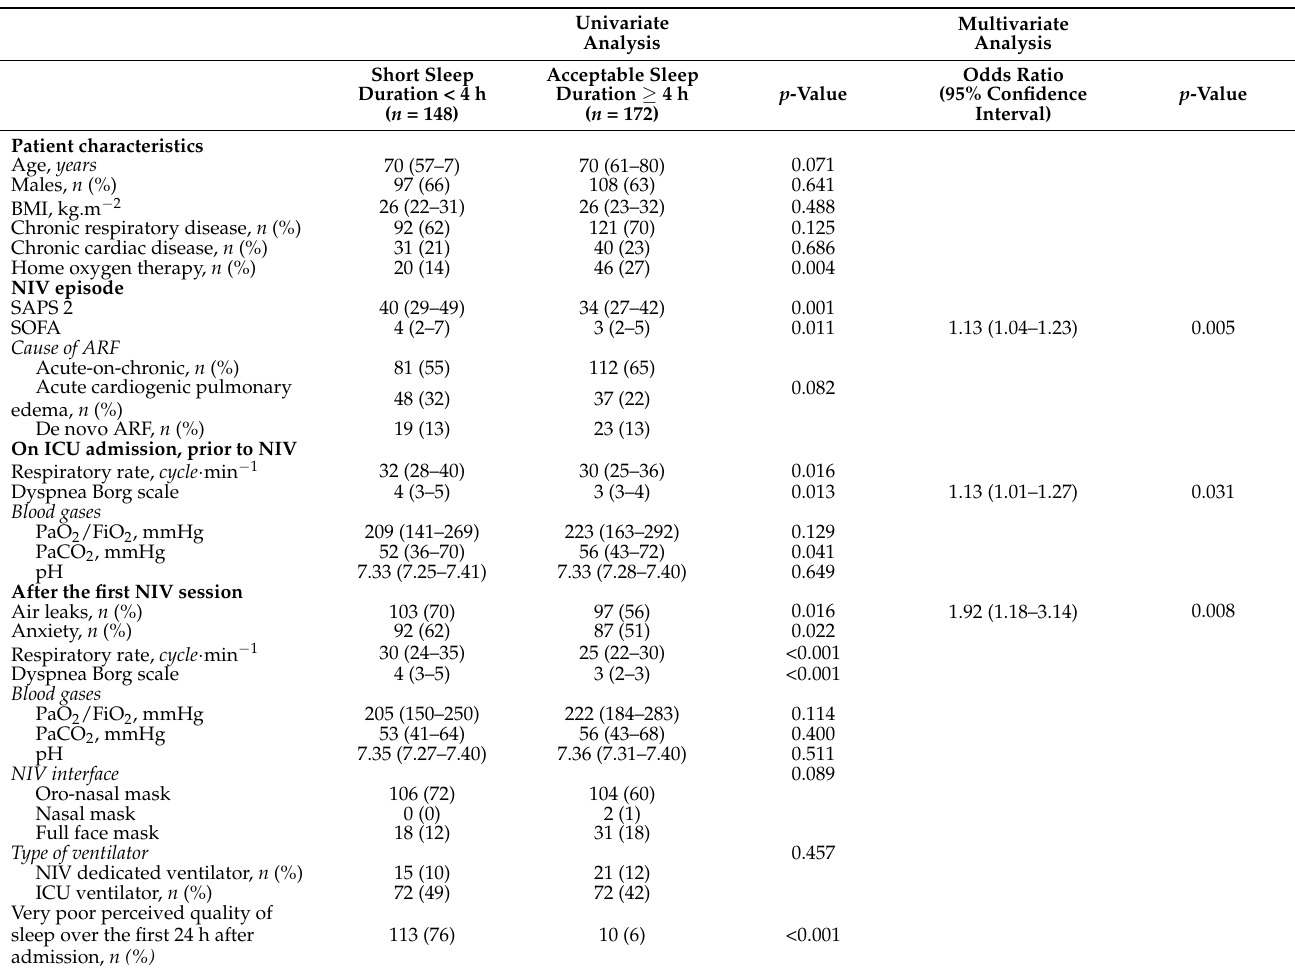
Table 2. Univariate and multivariate analysis: factors associated with short (<4 h) estimated sleep